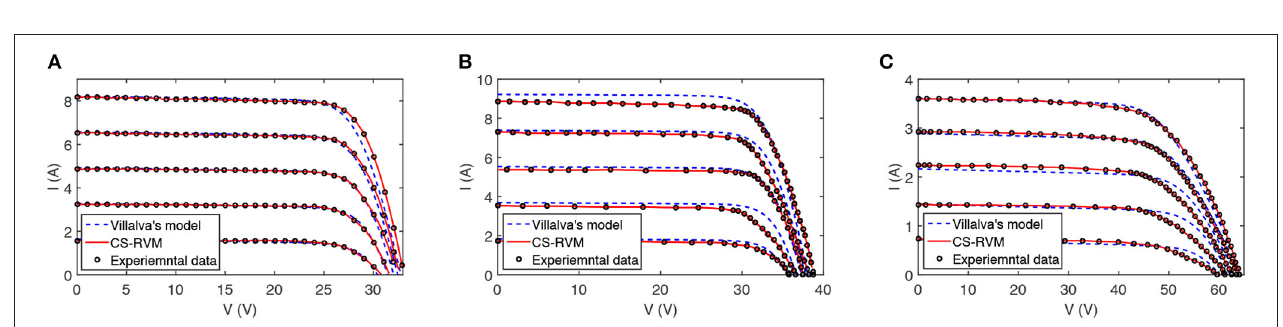
FIGURE 6 | I - V curves obtained by CS-RVM and Villalva’s model for various PV modules: (A) KC200GT (multicrystal), (B) STP 265S20 (monocrystalline), (C) TS-150C1 (thin film).